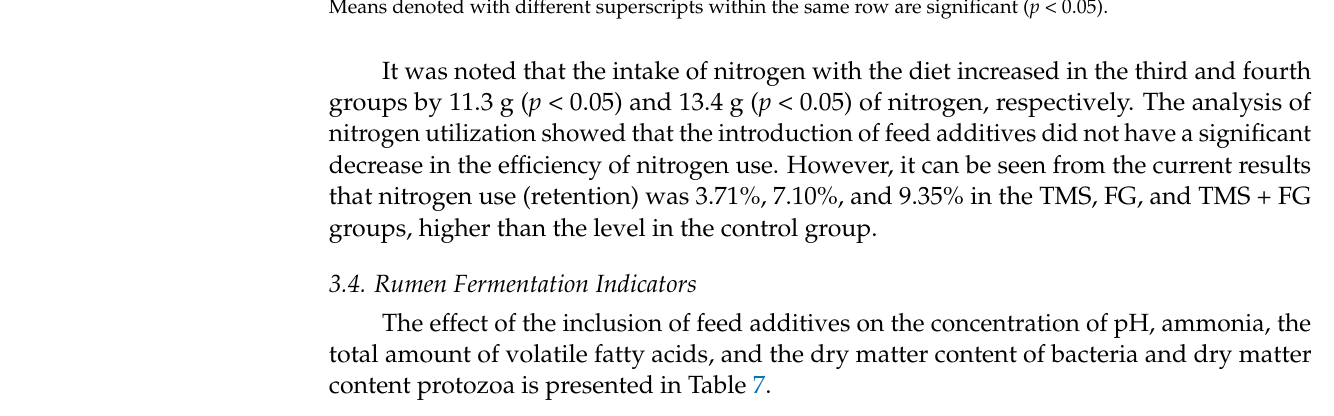
Table 7. Indicators of fermentation in the rumen of dairy cows of the Suksun